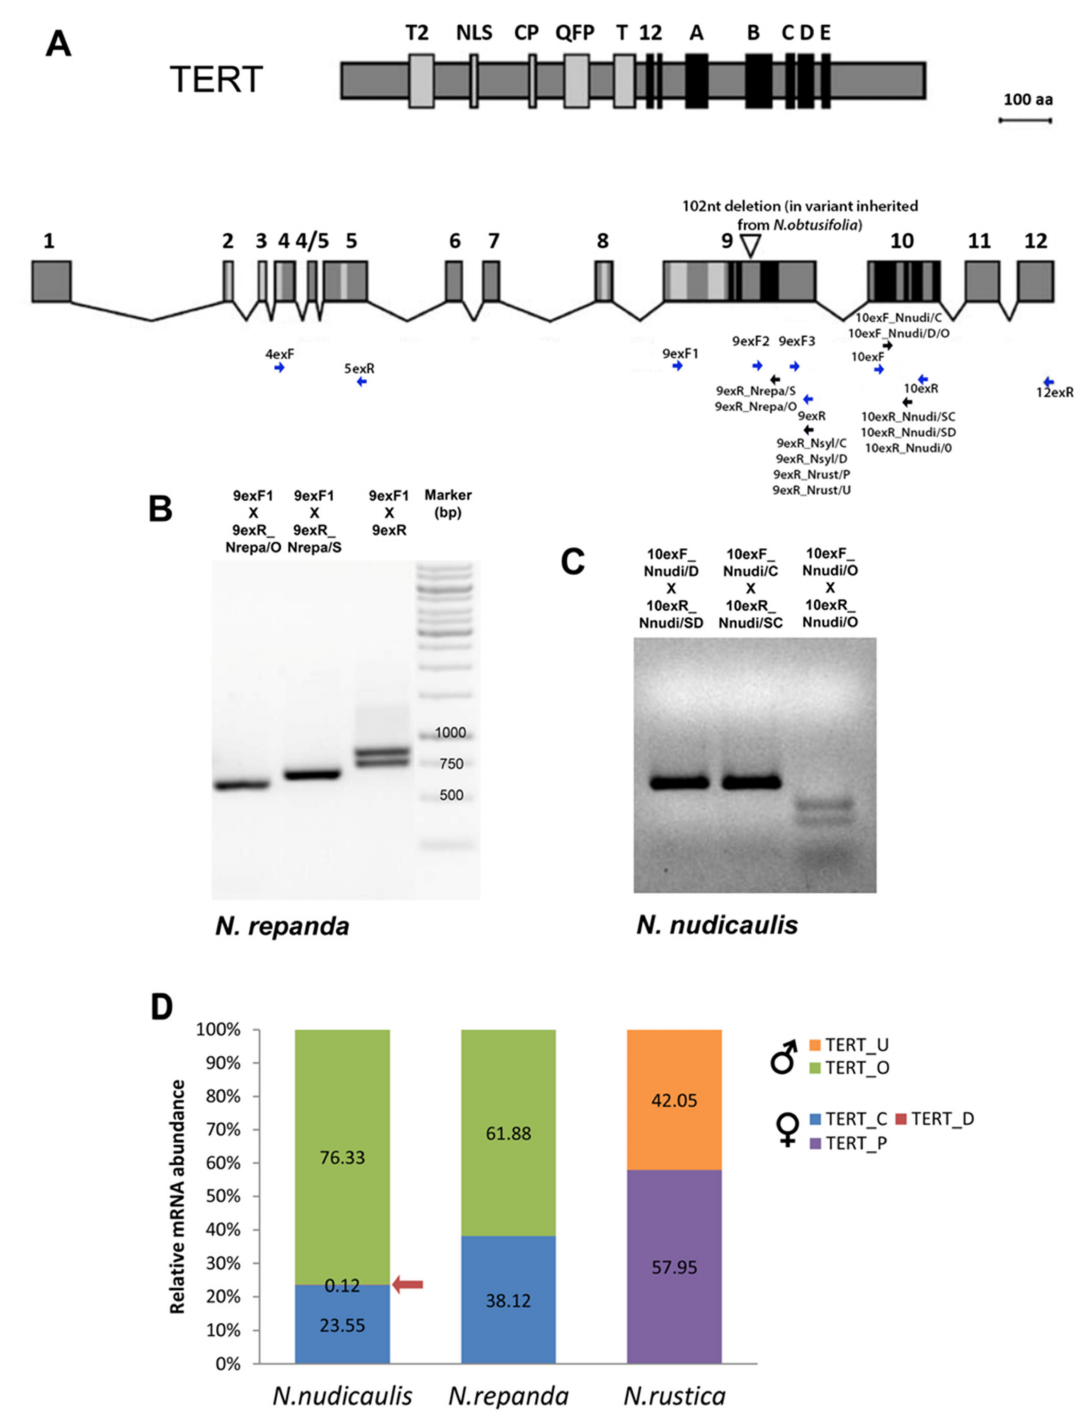
Figure 2. Experimental identification of TERT variants and analysis of gene expression in Nicotiana polyploids. ( A ) Con- served telomerase specific motifs (T2, NLS, CP, QFP, T) and reverse transcriptase motifs (1, 2, A–E) are highlighted in protein and mRNA of Nicotiana TERT (modified from [30]). Positions of primers used for screening experiments (blue arrows)